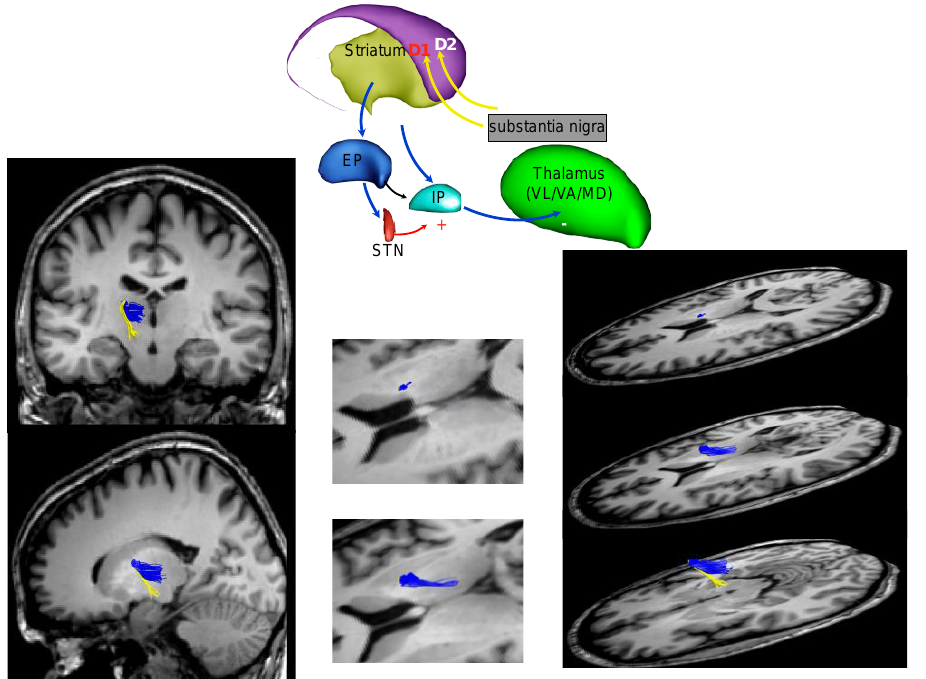
Figure 1. The fronto-striatal circuit (part a).